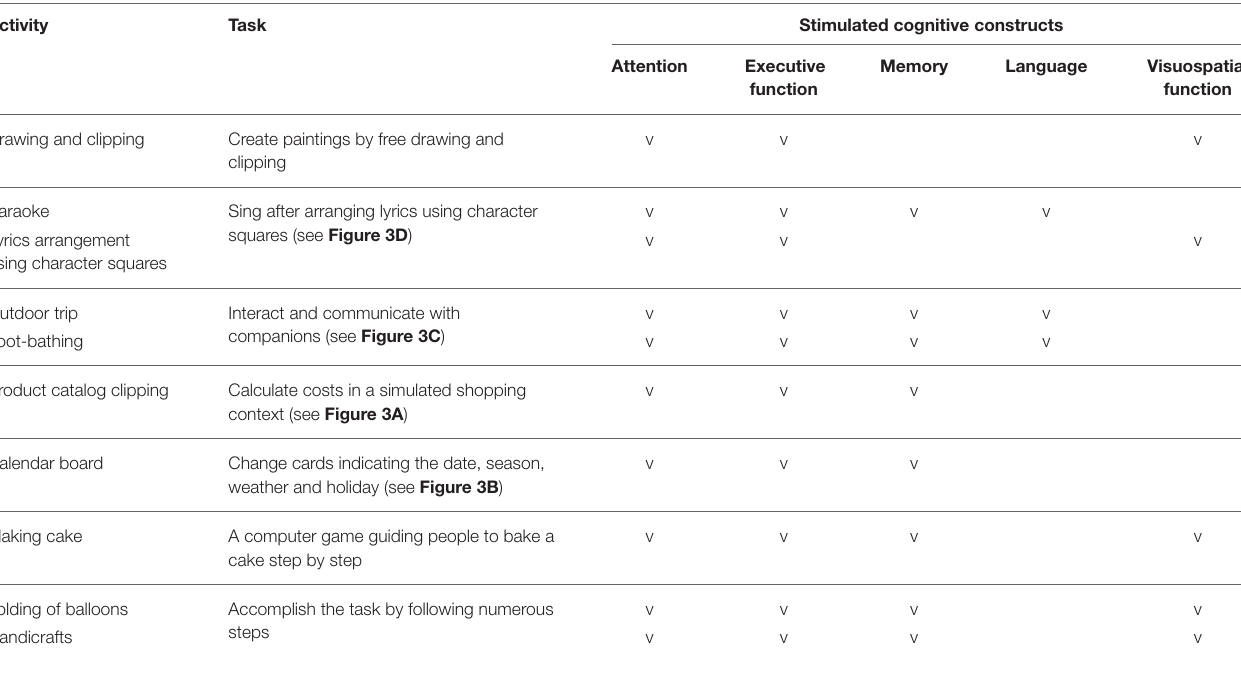
TABLE 4 | Cognitive training activities and effectiveness in the day-care nursing home.